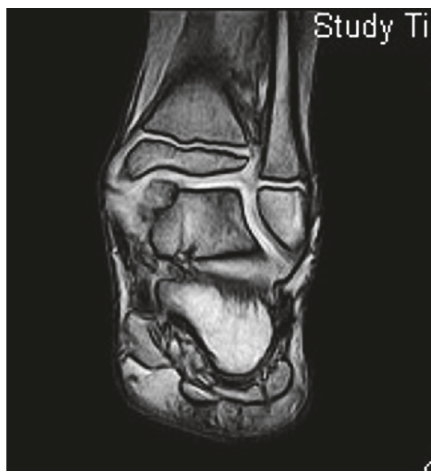
Figure 8: The MRI shows pedicled bone tumor arising from the talus.